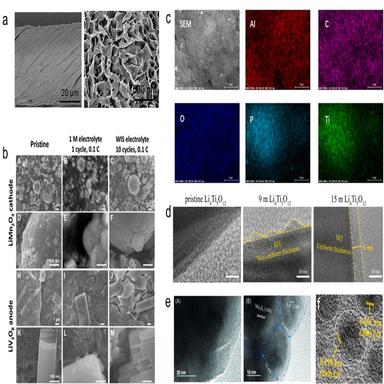
(a) SEM images of a PI/CNT hybrid fibre with a PI growth time of 6 h at different magnifications. (b) Surface morphological evolution of (A to F) the LiMn2O4 cathode and (H to M) the LiV3O8 anode. (A and H) Pristine states. (B and I) After one cycle at 0.1 C, 2.5 to 0.3 V, with the conventional 1 M LiTFSI:LiBETI electrolyte. (C and J) After 10 cycles at 0.1 C, 2.5 to 0.3 V, with the WiSE. (D to F and K to M) Higher-magnification SEM images of the electrodes in (A) to (C) and (H) to (J), respe